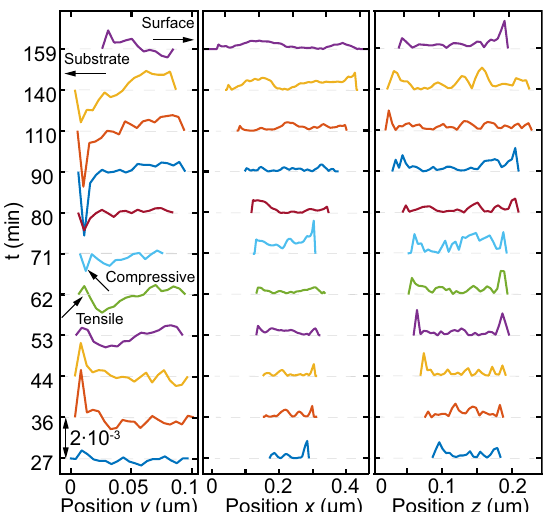
Fig. 4 Line pro fi les of the strain extracted from BCDI reconstructions at each time step in the annealing process. The axes correspond to those in Fig. 2a. All the graphs are on the same scale with a constant shift of 2 ⋅ 10 − 3 for